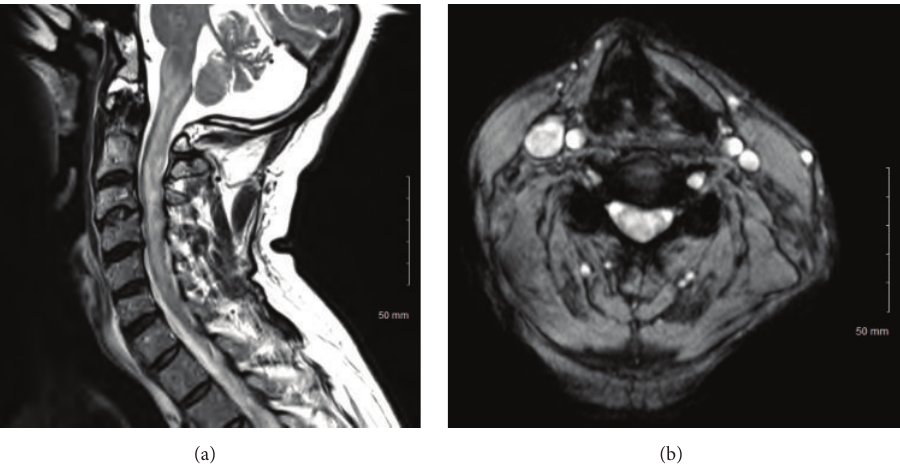
Figure 2: Preoperative T2-sequence MRI of the cervical spine. Sagittal (a) and axial (b) images showing diffuse spinal cord edema and T2-signal changes around the